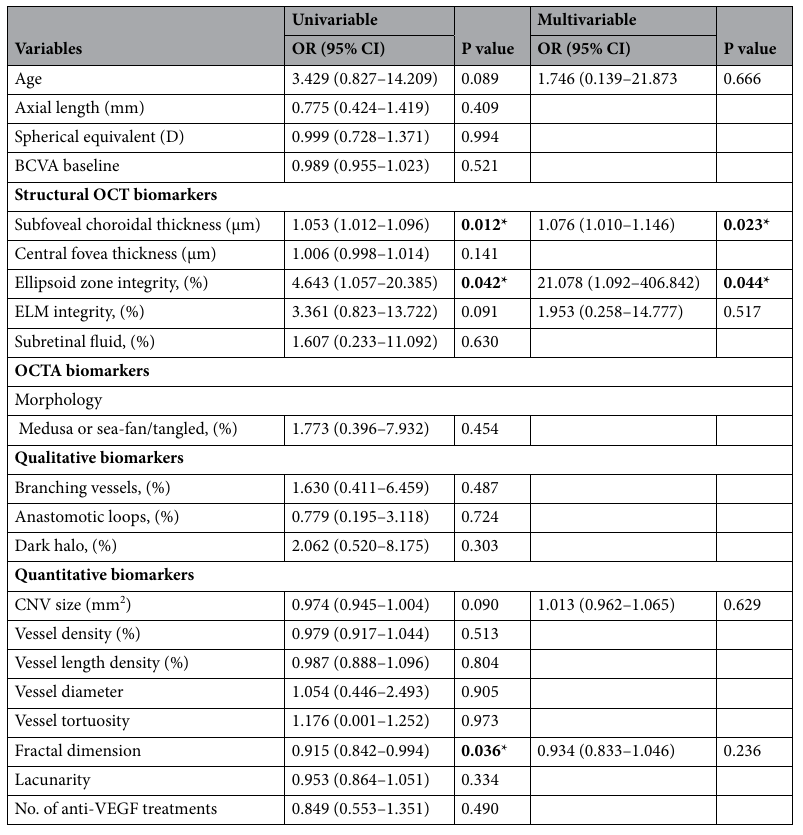
Table 2. Univariable and multivariable logistic regression analysis of baseline biomarkers associated with significant visual acuity improvement at 12-month. anti-VEGF: anti- anti-vascular endothelial growth factor; BCVA: best corrected visual acuity; CI: confidence interval; CNV: choroidal neovascularization; ELM: external limiting membrane; D: diopters; No.: numbers; OCT: optical coherence tomography; OCTA: OCT angiography; OR: odds ratio. *Statistically significant (P <